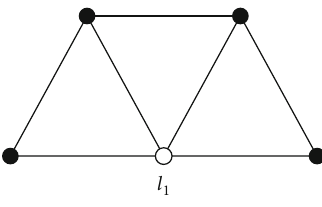
Figure 1: 1-apex